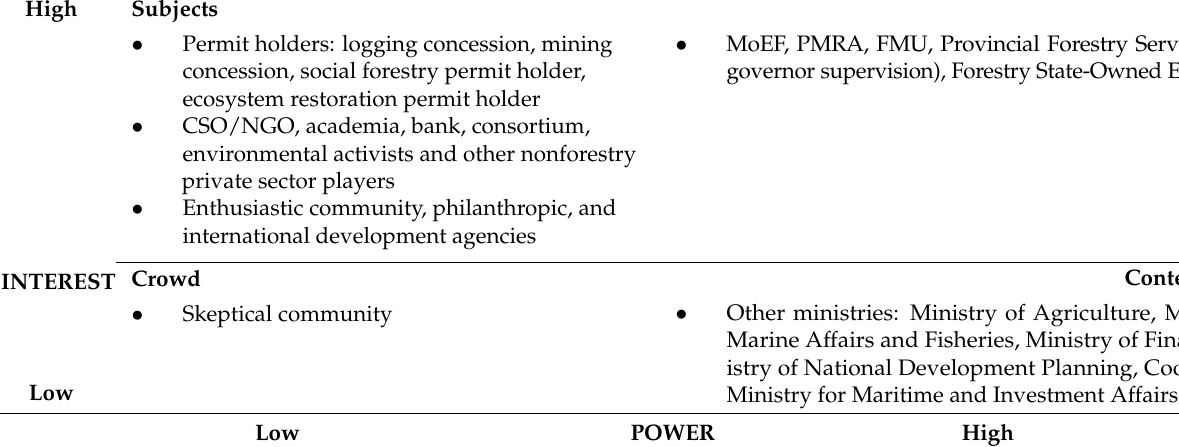
Table 3. Power-interest matrix of forest restoration in